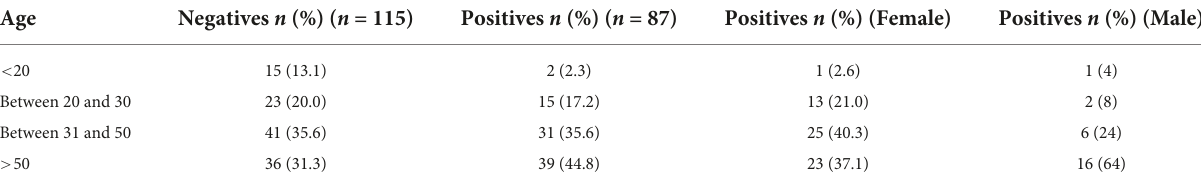
TABLE 3 Age distribution in the population studied by age group according to the presence of the human T-lymphotropic virus type 1 (HTLV-1) infection and gender.